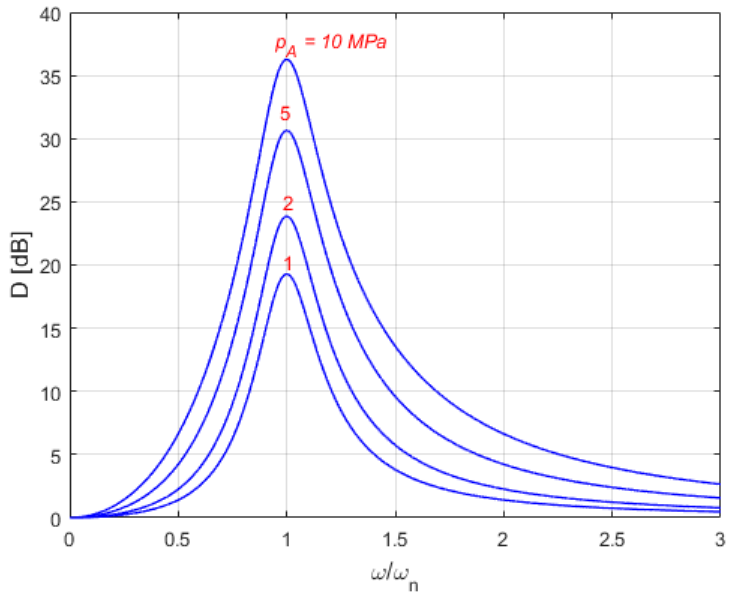
Figure 8. Damping efficiency index for different upstream pressures p A at the input voltage u = 5 V of the damping valve.